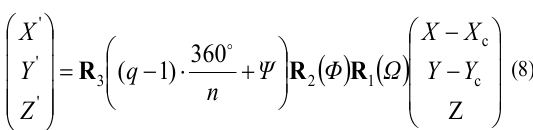
where R 0 is defined as the octagonal radius which is the distance between the centre and a vertex of the octagon on the XY -plane after the cone is transformed to be perpendicular to the XY -plane. Every point lying on the cone can be classified as belonging to position and q is defined as the octant number.